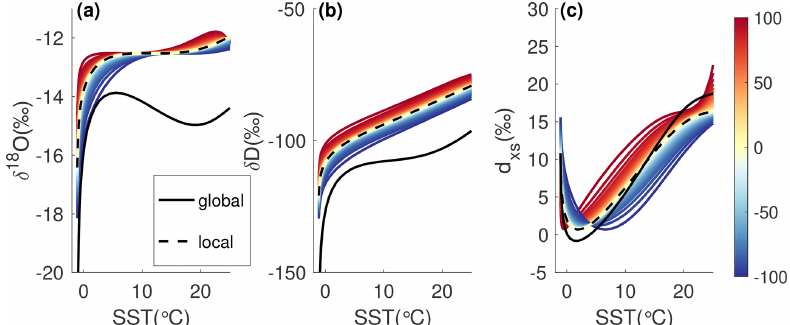
Figure A3. Relationship between isotopic composition of vapor and SST under different mixing scenarios. Positive values on the color scale reflect the fraction of moisture from a 5 ◦ C warmer moisture source mixed with the local moisture source (50 = 50% moisture from local source + 50% moisture from 5 ◦ C warmer-than-local moisture source), while negative values reflect the fraction of moisture from a 5 ◦ C colder moisture source mixed with the local moisture source ( − 50 = 50% moisture from local source + 50% moisture from 5 ◦ C colder- than-local moisture source). Model results use NCEP/NCAR reanalysis for SST and RH climatology. Unmixed model results for a local closure assumption are shown as a black dashed line and a global closure assumption as a solid black